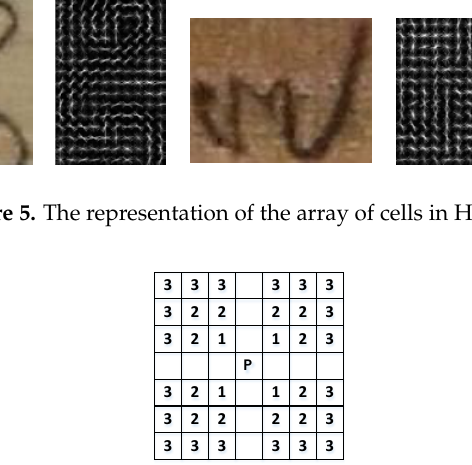
Figure 6. Neighborhood pixels for NPW features [28].